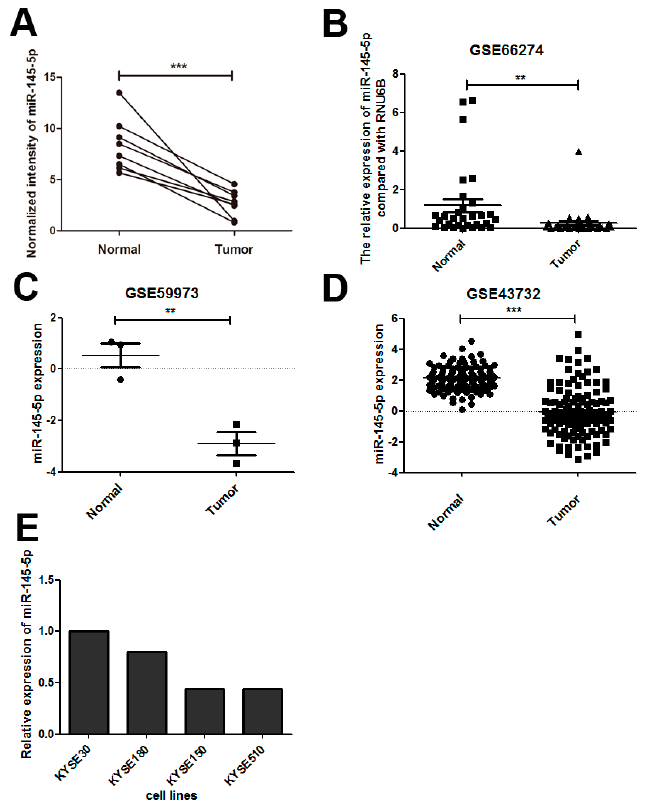
Figure 1. Down-regulation of miR-145-5p in esophageal squamous cell carcinoma (ESCC) tissues. ( A ) Microarray analysis of miR-145-5p expression level in eight paired ESCC tissues and adjacent normal tissues; ( B – D ) Low expression of miR-145-5p in ESCC tissues compared with their adjacent non-malignant tissues in the datasets of GSE66274, GSE59973 and GSE43732; ( E ) The expression of miR-145-5p in ESCC cell lines was detected by real-time polymerase chain reaction (RT-PCR). ** p < 0.01; *** p < 0.001.